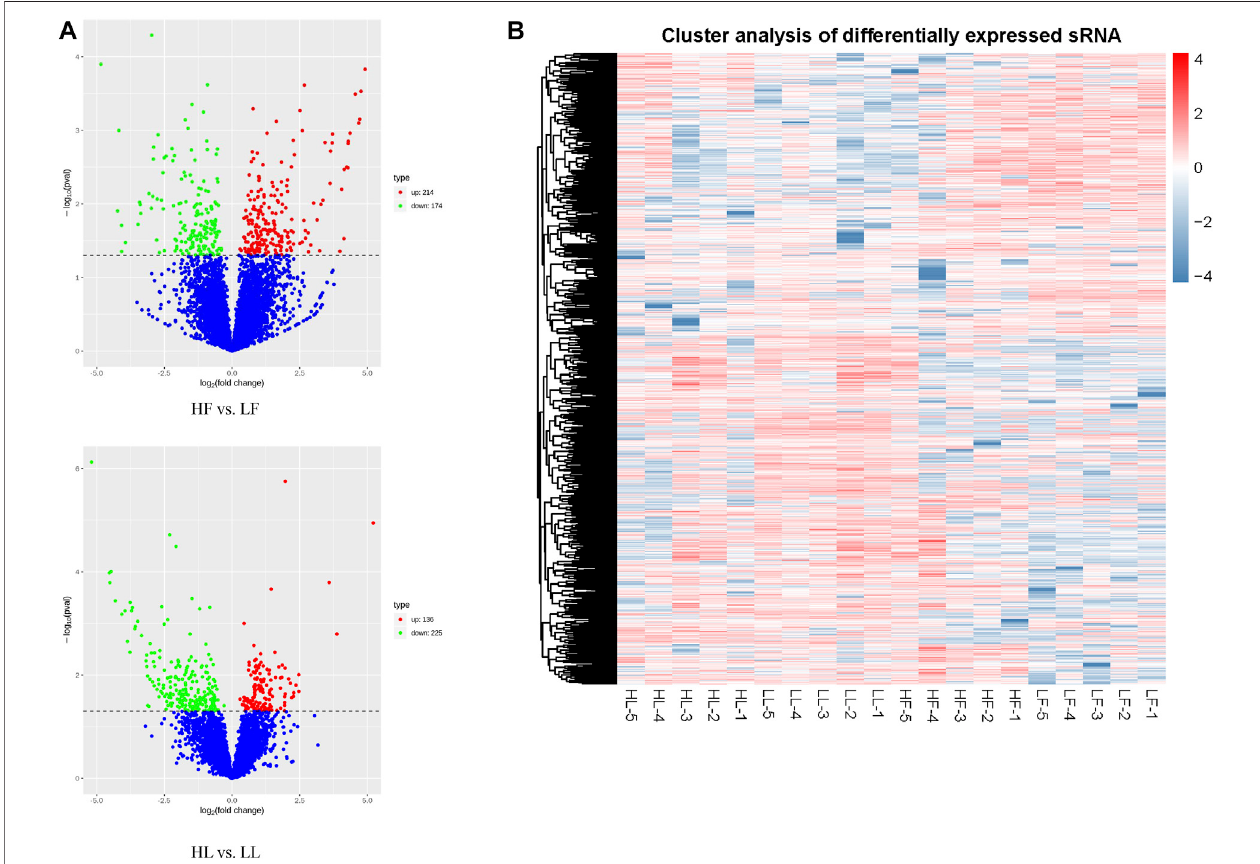
FIGURE 3 | Overview of differentially expressed circular RNAs (DE circRNAs). (A) A volcanic plot of high-yielding goats versus low-yielding goats in the follicular phase (HF vs. LF) and the luteal phase (HL vs. LL). (B) The expression pattern of DE circRNAs and hierarchical clustering analysis in the HF, LF, HL, and LL groups.